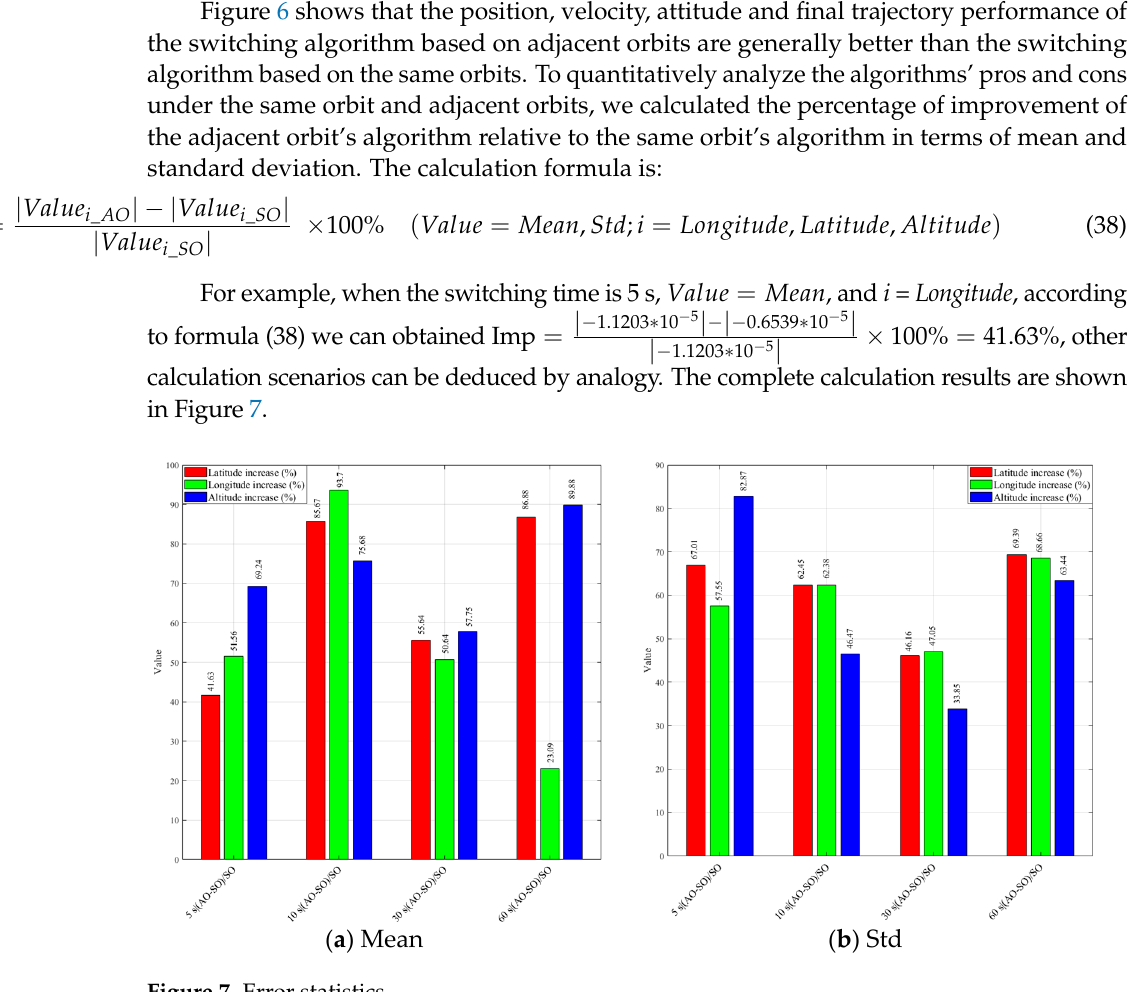
Figure 7. Error statistics.